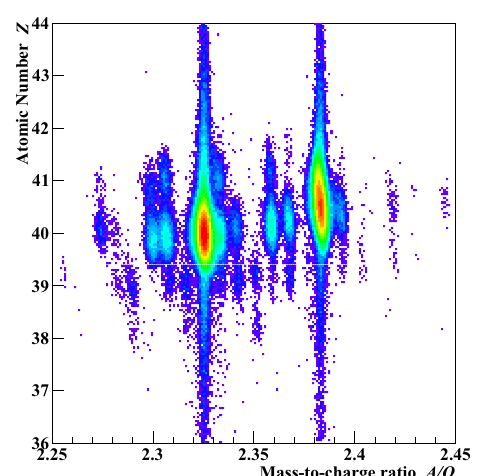
Figure 2. Particle identification plot for reaction products from the H target after selecting the 93 Zr 2